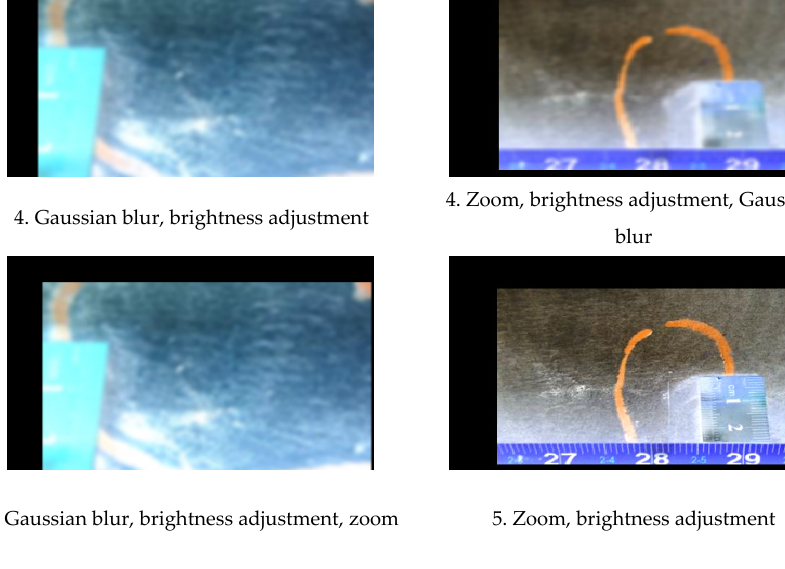
Figure 11. Image enhancement example of two images: ( a ) Random Image Enhancement Combination 1; ( b ) Random Image Enhancement Combination 2